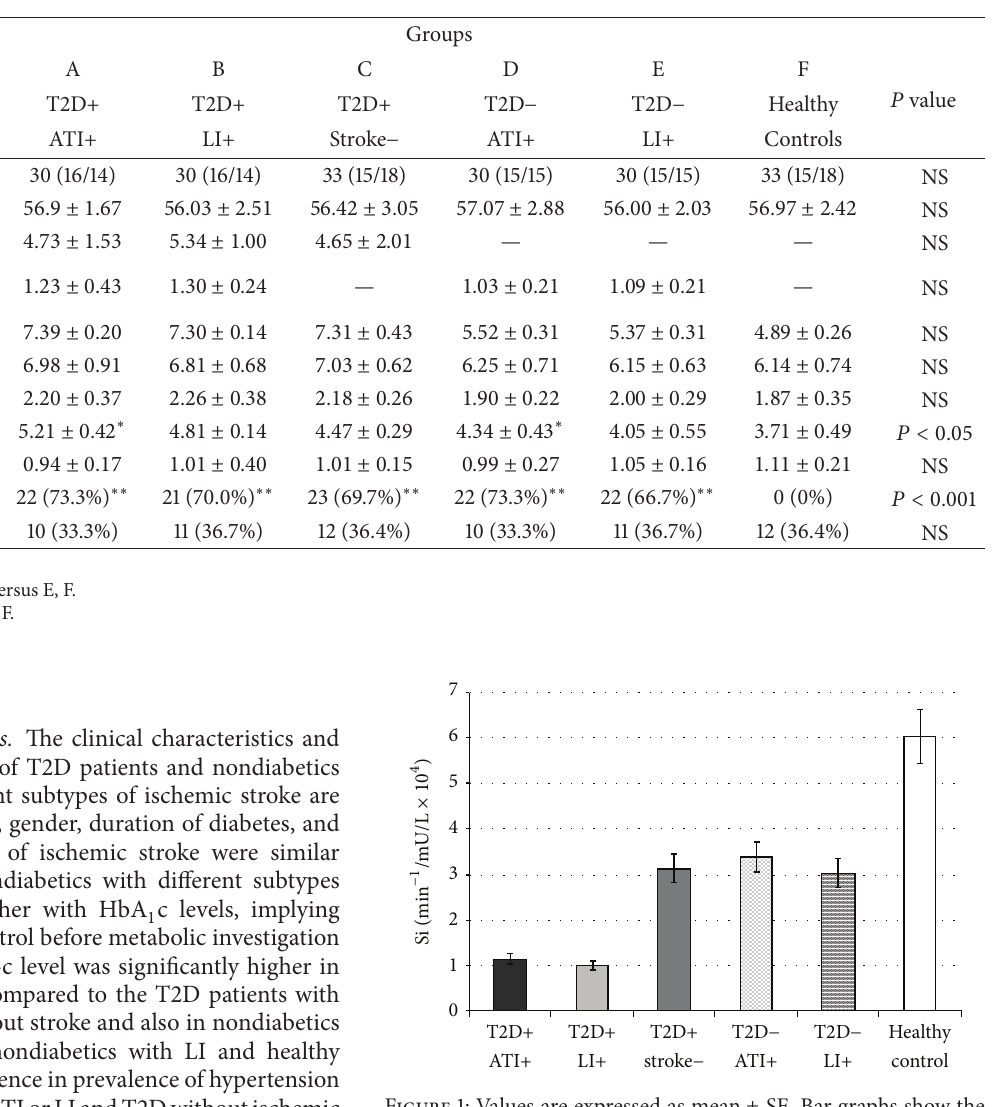
Table 1: Clinical characteristics and laboratory analyses in type 2 diabetic patients and nondiabetics with different subtypes of ishemic stroke: atherotrombotic infarction (ATI) and lacunar infarction (LI).